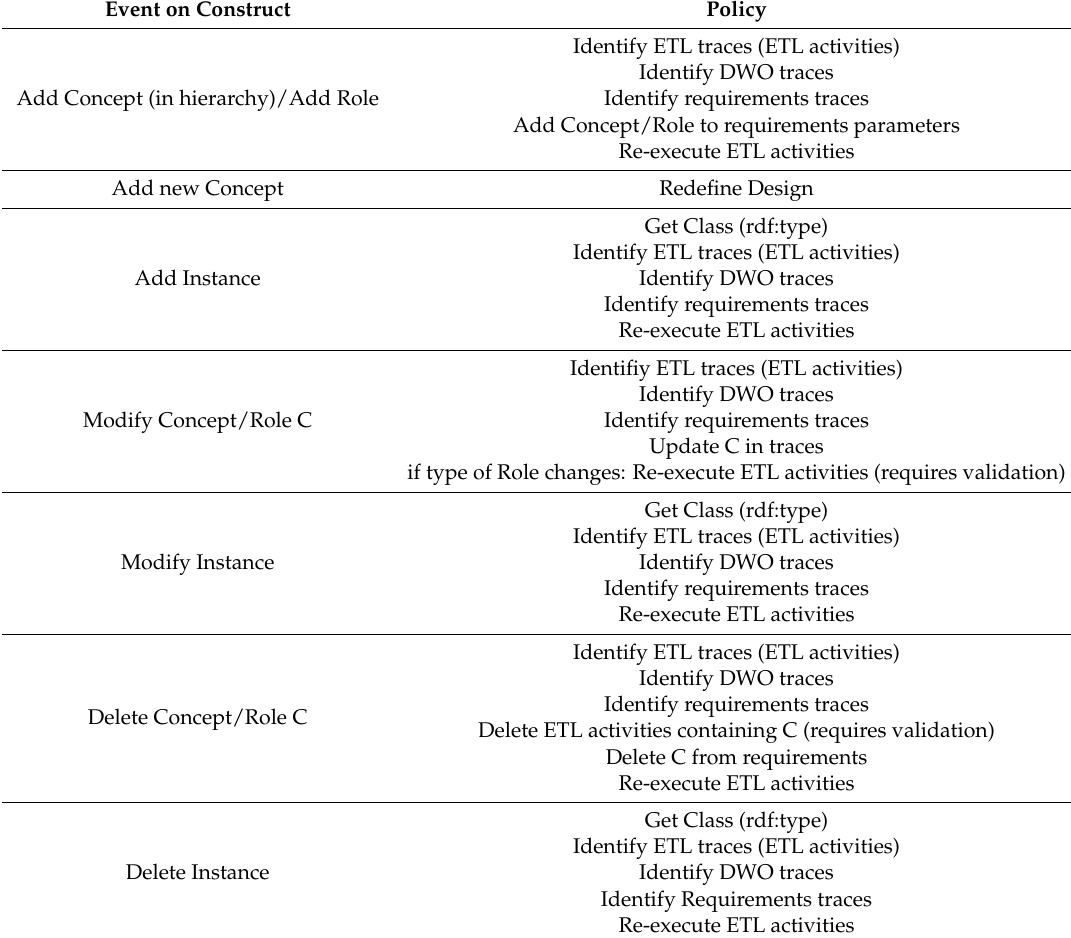
Table 1. Change management policies. DWO: DW